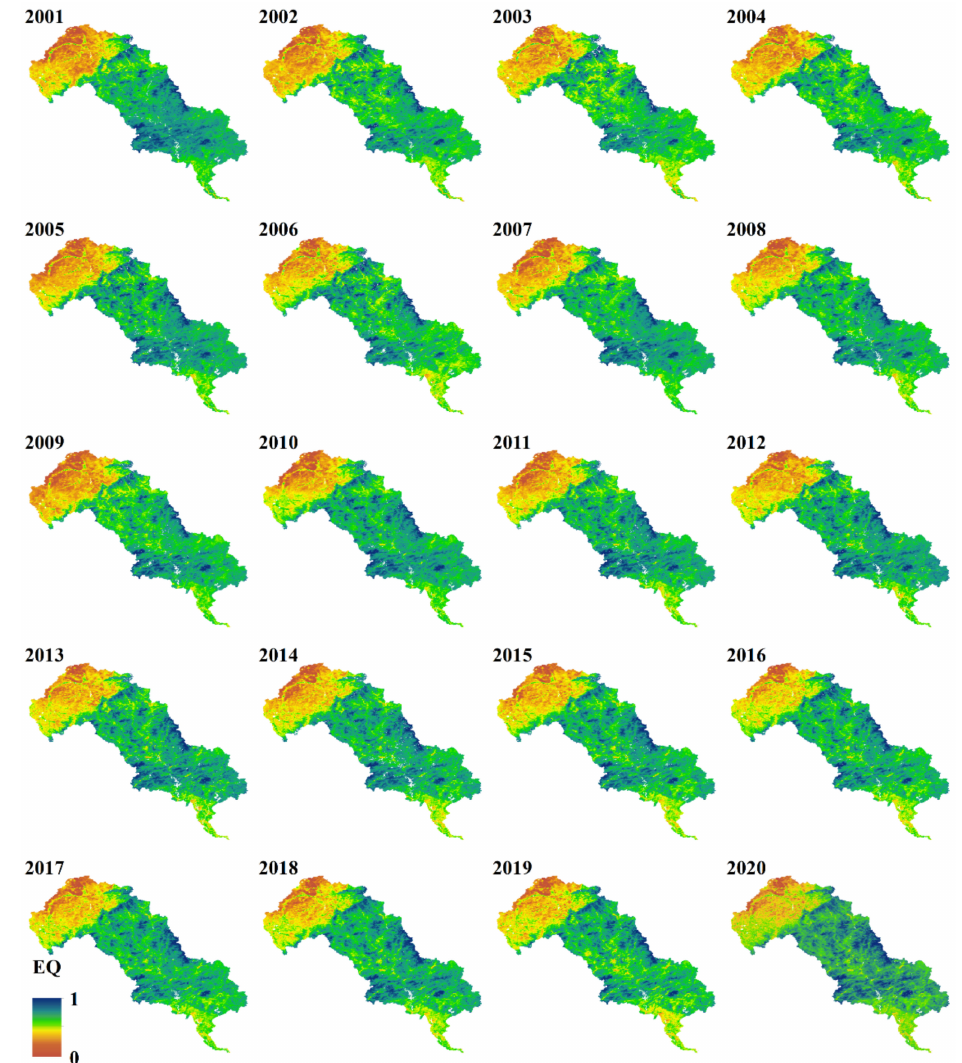
Figure 2. Spatial distribution of ecological quality of LHRB from 2001 to 2020.